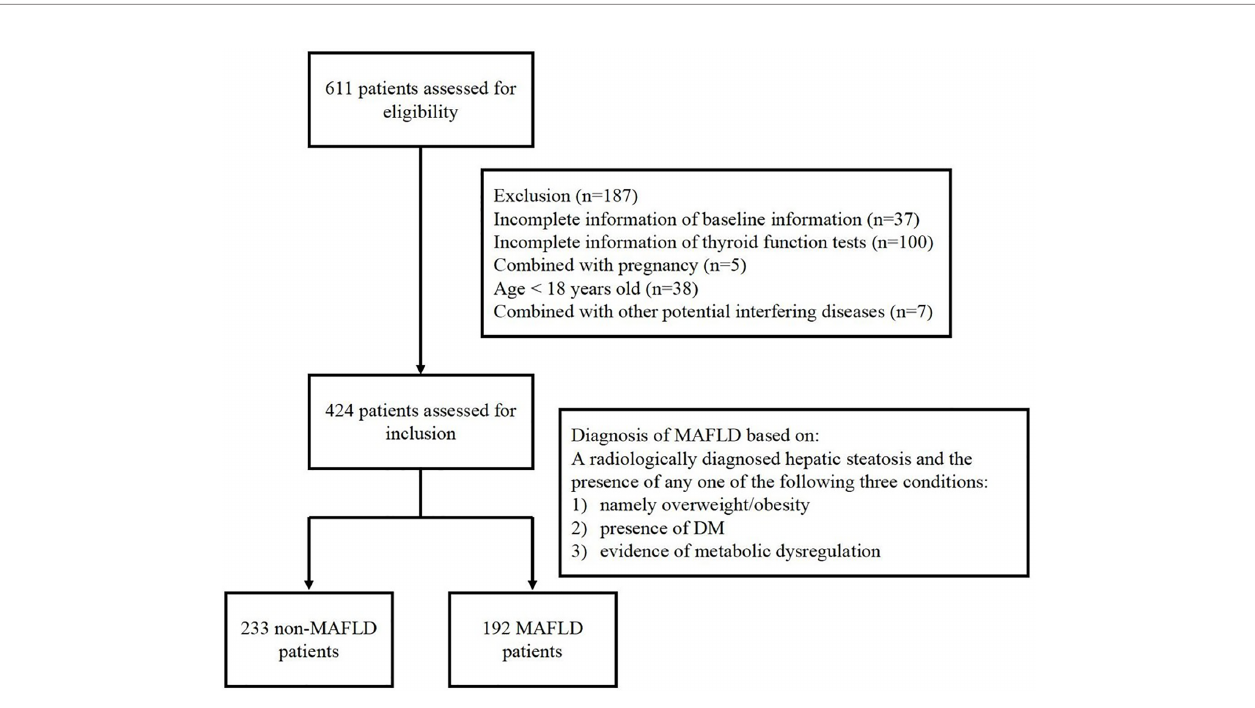
FIGURE 1 | Flowchart of the inclusion and exclusion of participants in this